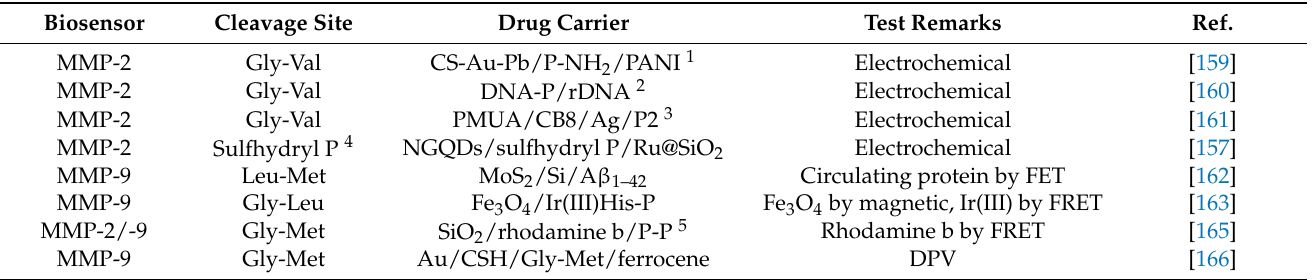
Table 10. Electrical triggers with added enzymatic biosensors and their cleavage sites in drug carriers with test